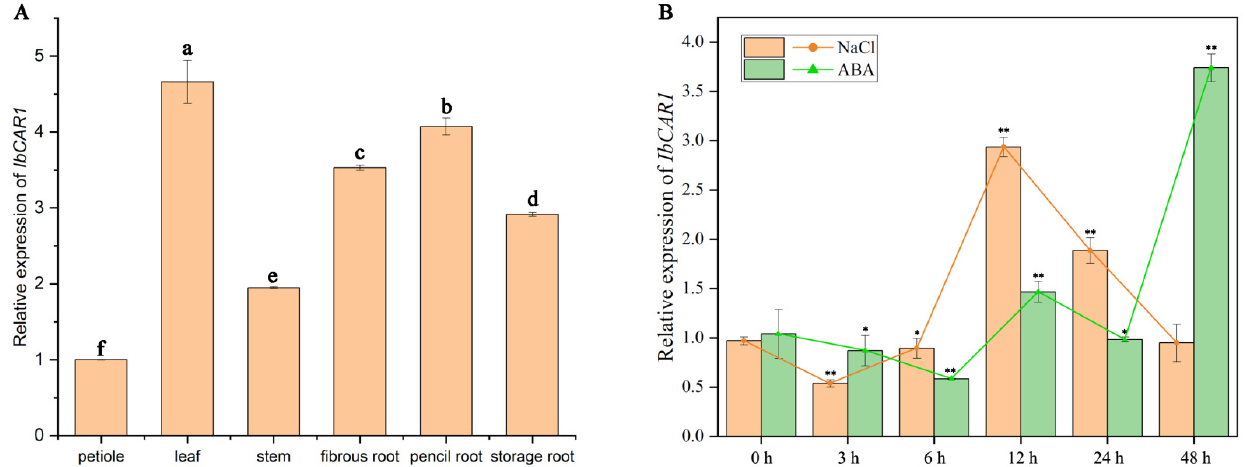
Figure 2. Expression analysis of IbCAR1 . ( A ) Expression analysis of IbCAR1 in storage root, pencil root, fibrous root, leaf, stem, and petiole tissues of Xuzishu8. Data are presented as means ± SE ( n = 3). Different lowercase letters indicate a significant difference at p < 0.05 based on Student’s t -test. ( B ) Expression analysis of IbCAR1 in whole plants of Xuzishu8 after different times (h) in response to 200 mM NaCl and 100 mM ABA, respectively. The sweet potato b-actin gene was used as an internal control. Data are presented as means ± SE ( n = 3). ** indicates a significant difference compared with 0 h ( p < 0.01) based on Student’s t -test. * indicates a significant difference compared with 0 h ( p < 0.05) based on Student’s t